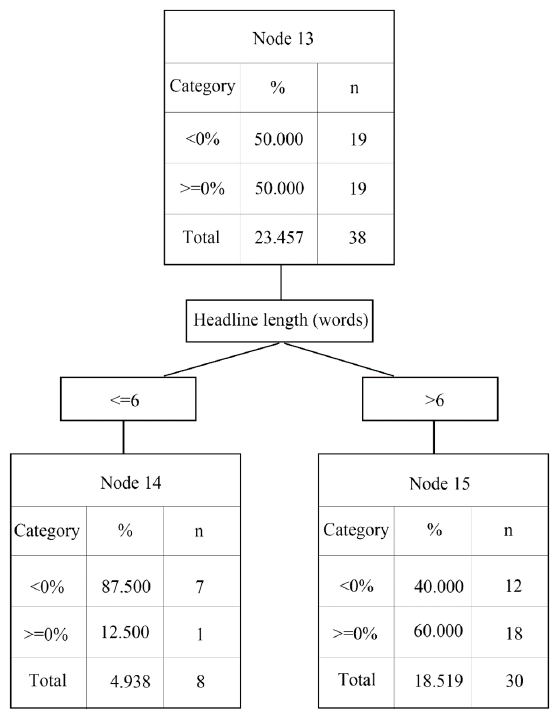
Figure 8. The classification results for N06 (The New York Times) at Nodes 13–15. Big Data Cogn. Comput. 2019 , 3 FOR PEER REVIEW